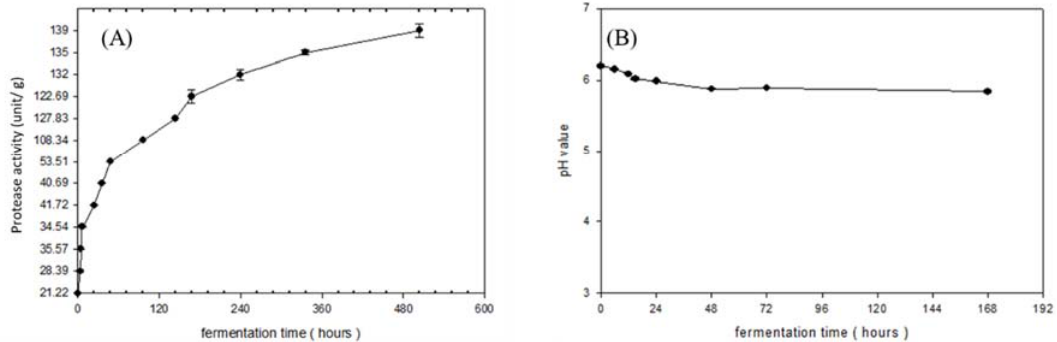
Figure 1. The fermentation time of the protein decomposing ( A ) enzyme activity; and ( B ) pH value changes.